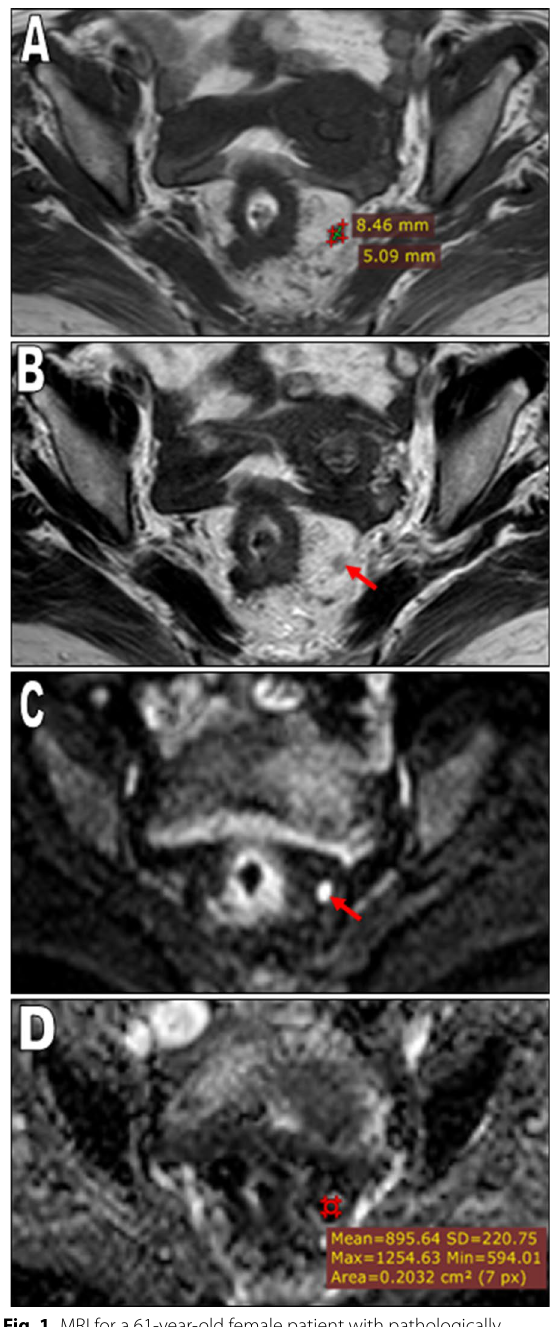
Fig. 1 MRI for a 61-year-old female patient with pathologically proven rectal adenocarcinoma presented clinically by bleeding per rectum. A Axial T1 WI and B Axial T2 WI showed enlarged left peri-rectal lymph node measuring about 8.5 5.1 mm at maximum × axial dimensions, eliciting intermediate T1, heterogeneous high T2 signals, has an oval configuration with irregular borders, morphologically it is considered to be suspicious lymph node C DWI and D ADC map showed restricted diffusion; with the predominant bright areas on DWI corresponding to low signal areas on the ADC map ADC mean 0.89 10 –3 mm 2 /s. Histopathological analysis = × confirmed metastatic nature of the examined lymph